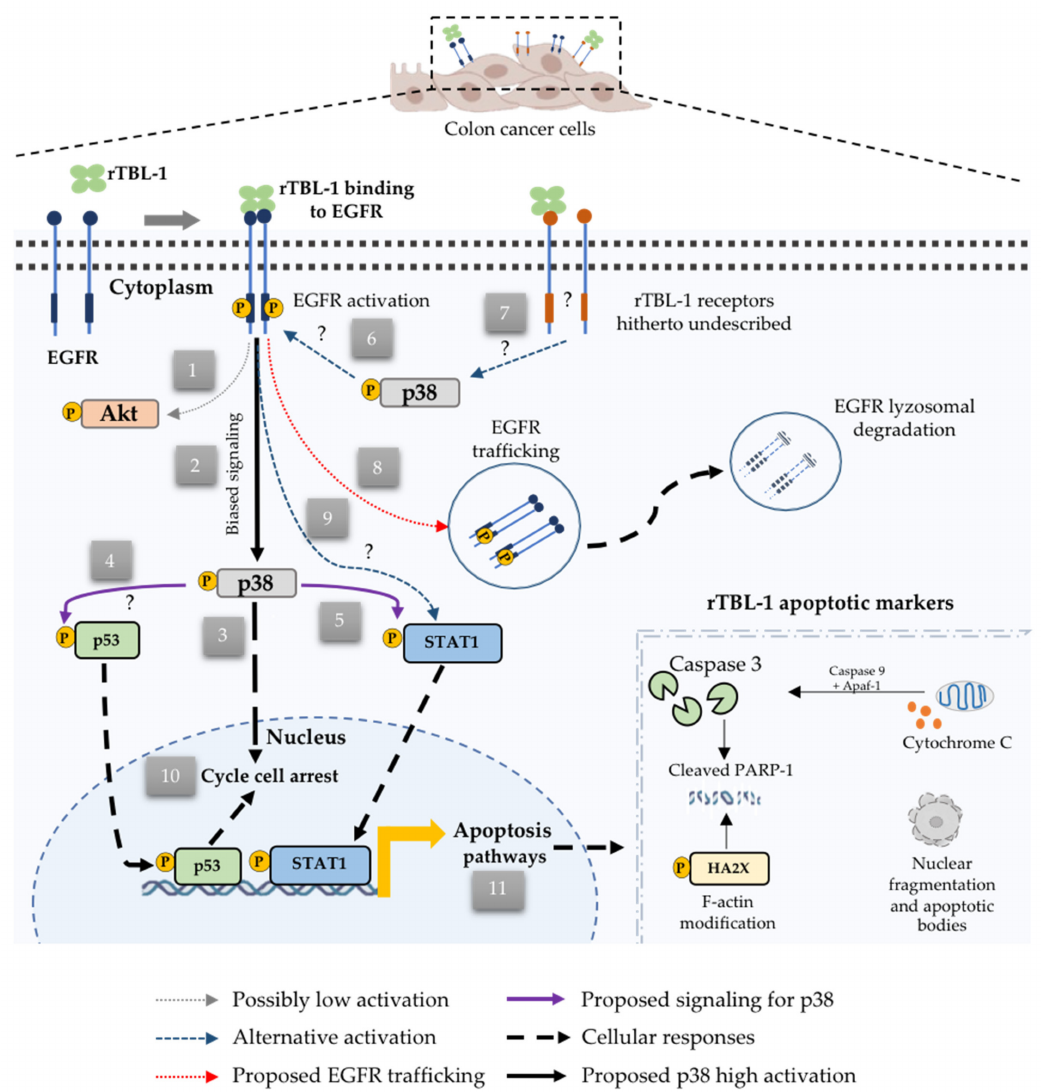
Figure 11. The proposed apoptotic mechanism for rTBL-1 through EGFR binding. rTBL-1 binds to EGFR or to hitherto undescribed receptors. (1) Low Akt activation inhibits cell proliferation and blocks inhibitory signaling for apoptosis. (2) Induction of EGFR-biased signaling provokes high activation of p38. (3) Translocation and signaling of p38. (4) Activation of p53. (5) Activation of STAT1. (6) Possible retroactive interaction between p38 and EGFR. (7) Possible activation of p38 by the interaction of rTBL-1 with other membrane receptors. (8) Partial lysosomal degradation of EGFR after the interaction with rTBL-1. (9) Other routes of STAT1 activation through rTBL-1-EGFR binding. (10) Effect on cell cycle arrest. (11) Identified apoptotic markers for rTBL-1 on human colon cancer cells. Figure was captured using the BioRender platform (https://biorender.com accessed on 28 December